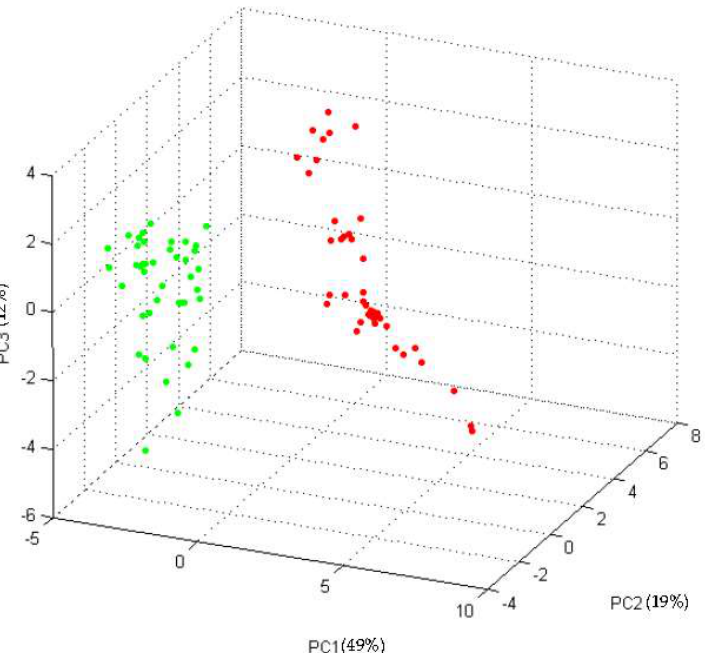
Figure 1. Three-dimensional plot of the spectra of the “training set” strains obtained by Principal Component Analysis (PCA) (dots of the same colour represent replicates of strains of the same class: colR-Ec strains in red and colS-Ec strains in green). For each principal component (PC), the percentage of the “explained variance” is reported in round bracket.